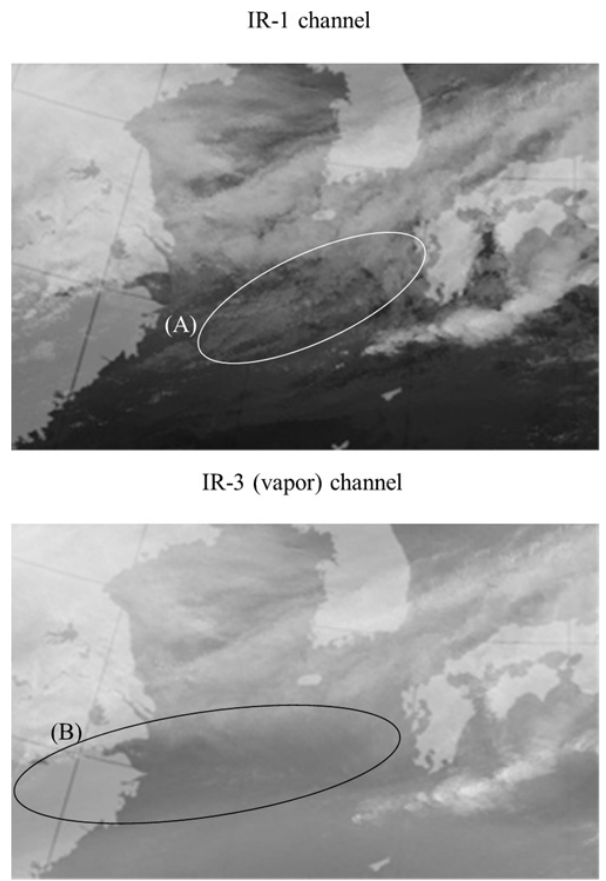
Fig. 8. MTSAT visible images over the East China Sea. A snapshot at 23:30UTC on 24 February 2009.